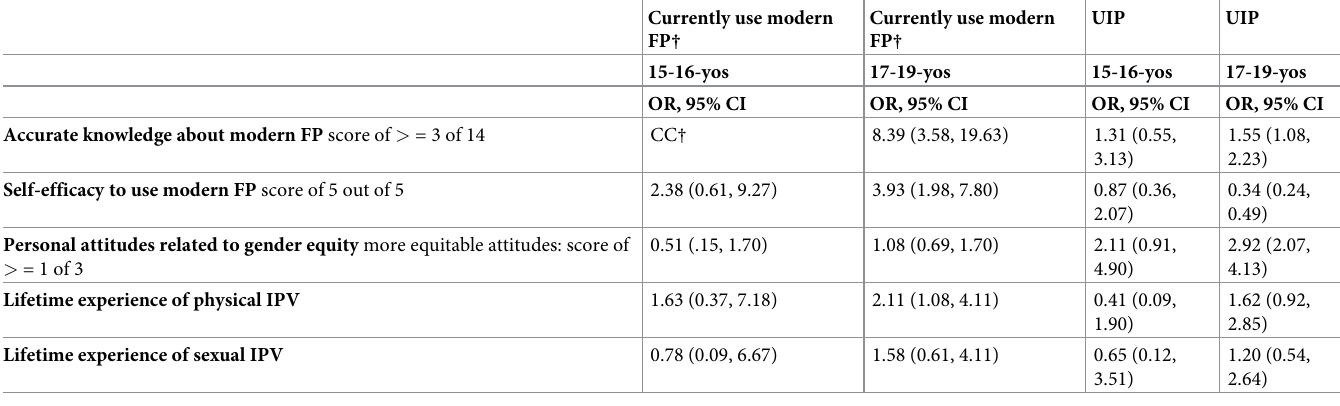
Table 6. The association between reproductive health, gender equity, and partner violence factors with current modern FP use and UIP experienced among married AGYWs in Dosso region, Niger, stratified by age, 15-16-year-olds and 17-19-year-olds, adjusted for parity status �